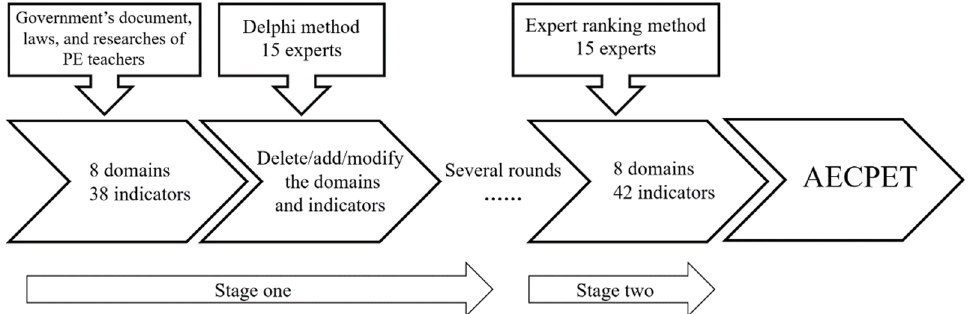
Figure 2. The AECPET research